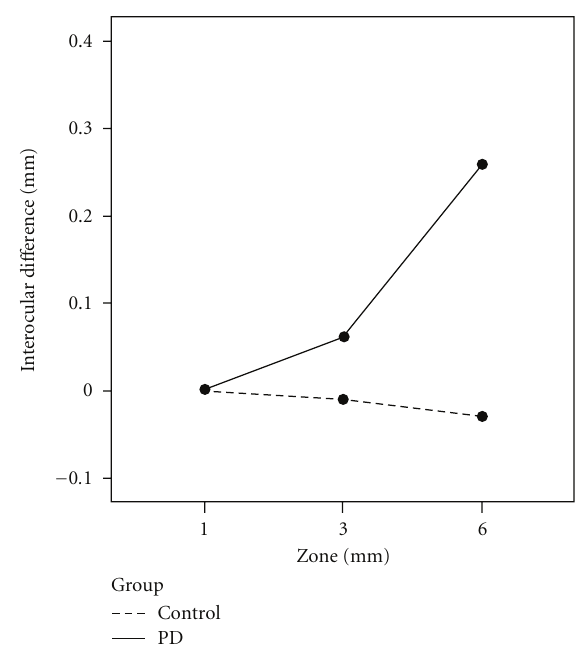
Figure 2: This figure shows interocular asymmetry in the average macular volume measured in the three “standard” (ETDRS) peri- foveal zones. The di ff erence increases with zone diameter (5mm) and reaches statistical significance only when the total macular volume (Zone 3) is compared (see Methods) between PD and con- trol